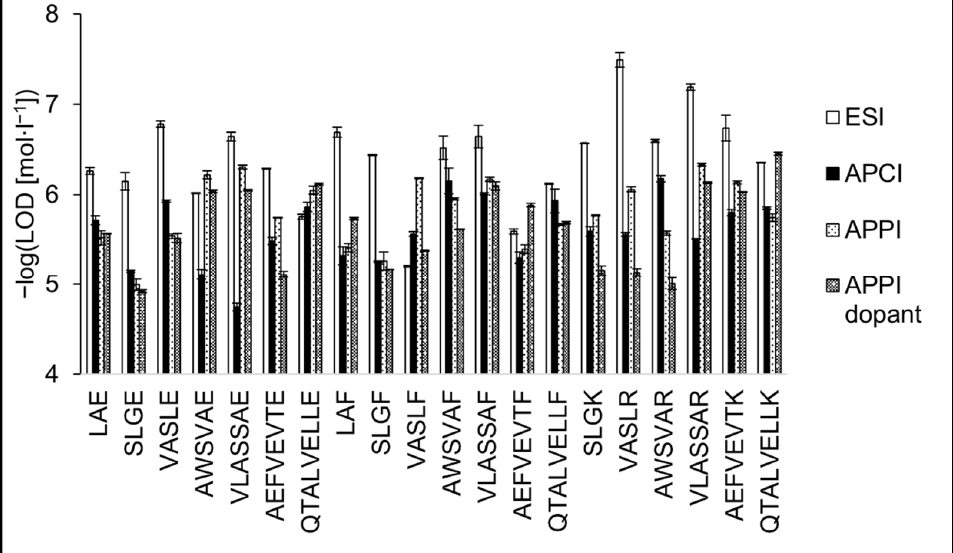
peptide chain length. Limits of detection with error bars are shown in Table 1. Tabulated Table 1. Tabulated figures of merit for all peptide standards are provided in Tables S1–S4. figures of merit for all peptide standards are provided in Tables S1–S4.